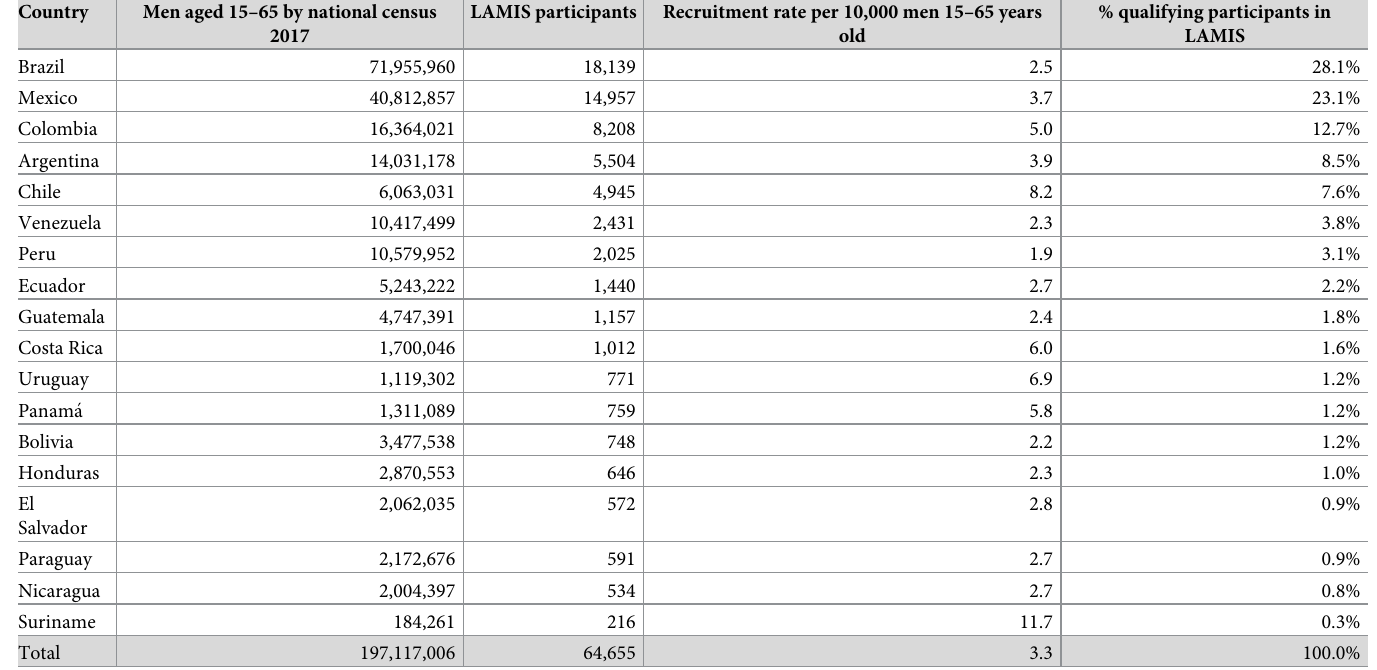
Table 2. Recruitment rate in LAMIS-2018 by country.